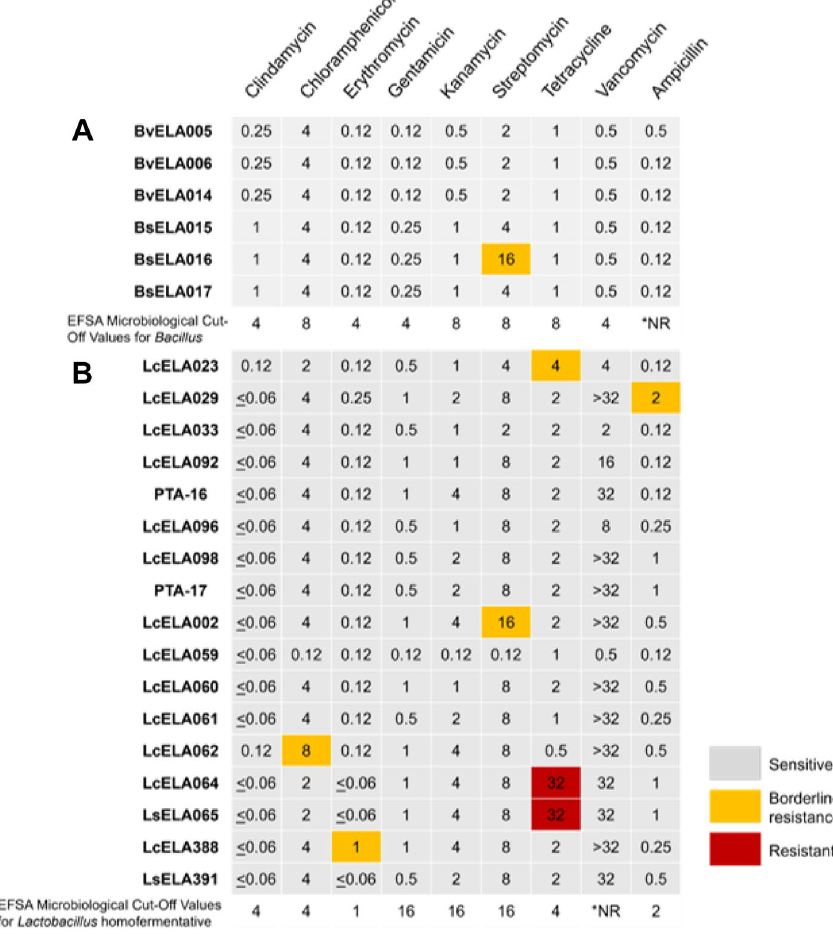
Figure 2. Antimicrobial susceptibility of Bacillus and Lactobacillus strains. MIC (μg/mL) values for each antibiotic tested against the respective genus are shown. Nine medically important antibiotics at a concentration range of 0.06–32 μg/mL were tested, and the respective antimicrobial susceptibility cut-off concentrations required for that genus are shown at the bottom of each panel. *NR = not required by EFSA. The results are representative of 3 independent